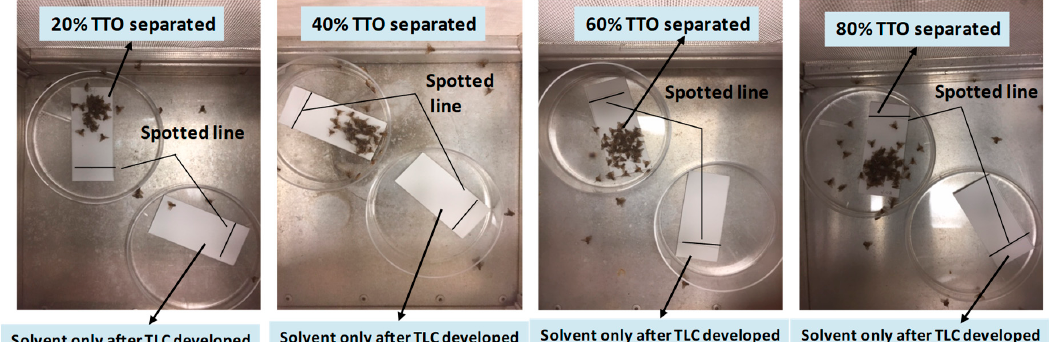
Figure 3. Development of effective dose responses using bioassays of male medflies. A 10 μ L of 20%, 40%, 60%, and 80% TTO was applied individually to TLC plates and developed with a mixture of solvent n -hexane:acetone (90:10, v/v ). Pictures were taken after 15 min. Photo credit: Micah Gill (USDA-ARS, SHRS).